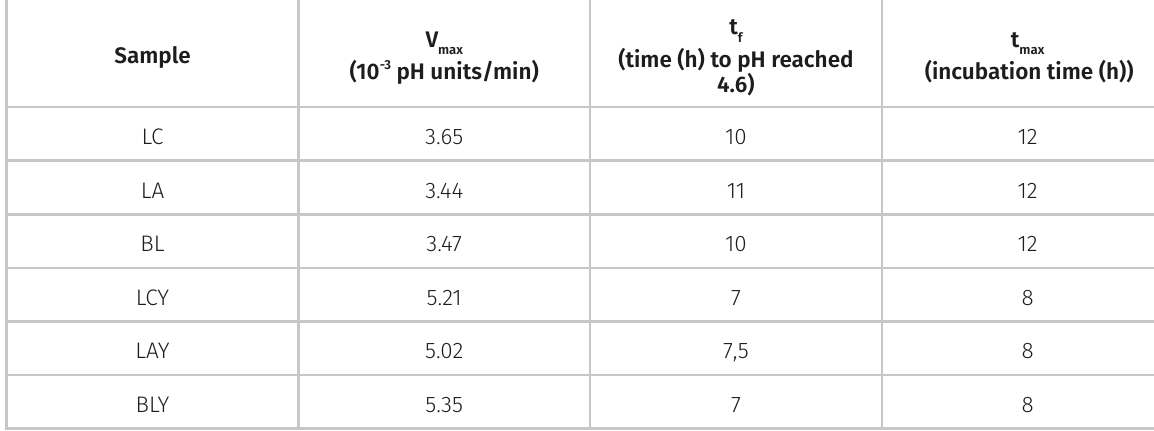
Table I. Acidification kinetics of yogurt samples.